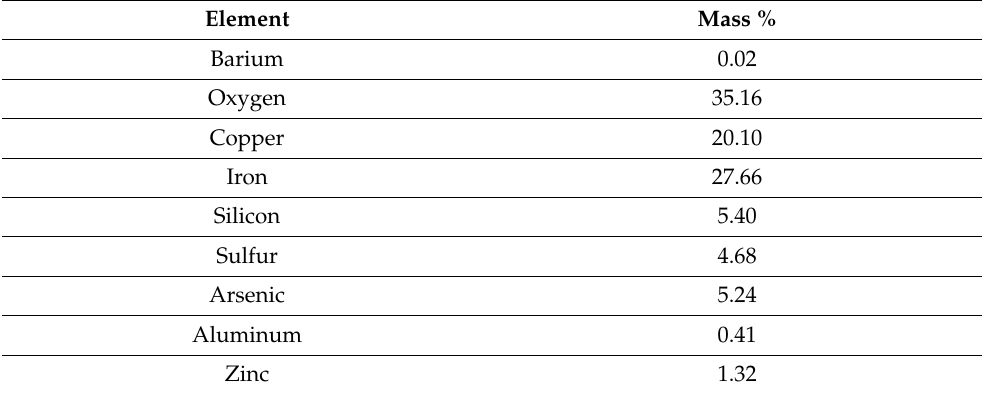
Table 4. AMICS elemental composition data for FF-ESP dust.